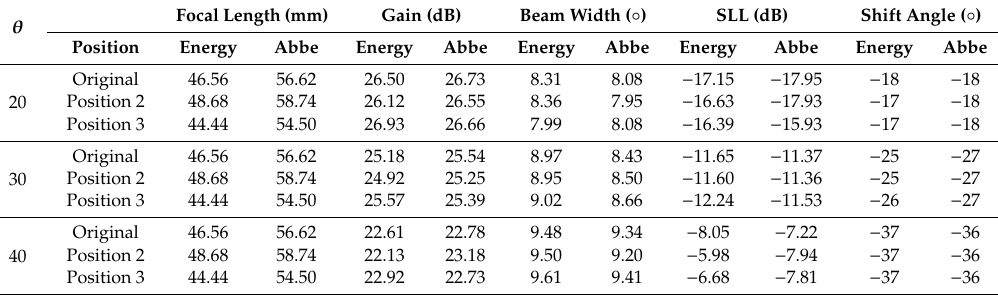
Figure 27. Antenna gain for all feed position for Abbe’s sine lens. Table 11. Performance for all positions at 20 ◦ , 30 ◦ and 40 ◦ scanning